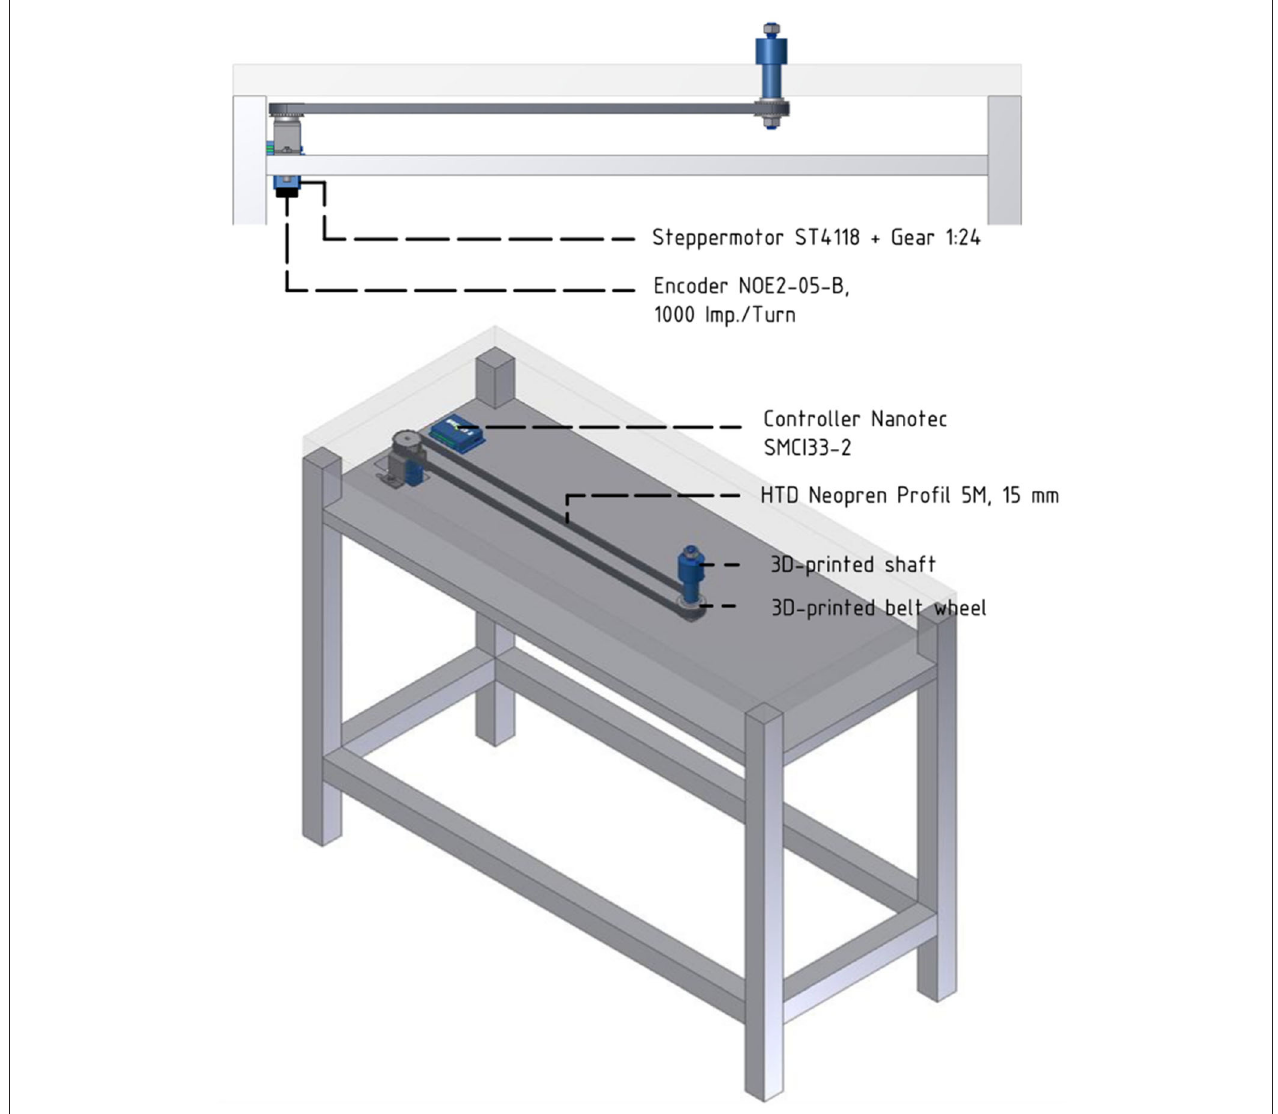
FIGURE 3 | Overview over the motor control and belt system. Below the tabletop an extra level of the table houses the belt and motor system. The turntable (not shown) will be placed on top of the 3d-printed shaft and cogwheel, which fits the toothed belt connecting shaft and